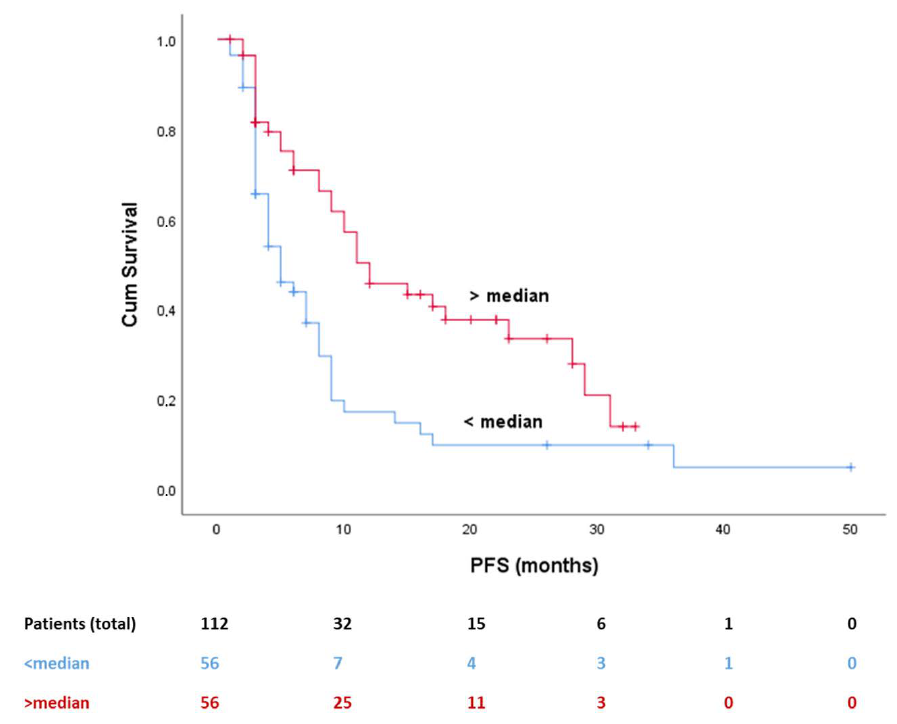
Figure 1. Kaplan–Meier curve for PFS and PIOS (median value used as cutoff point). Abbreviations: PFS, progression free survival; PIOS, Patras Immunotherapy Score. Table 2. Univariate and multivariate analysis for PFS.